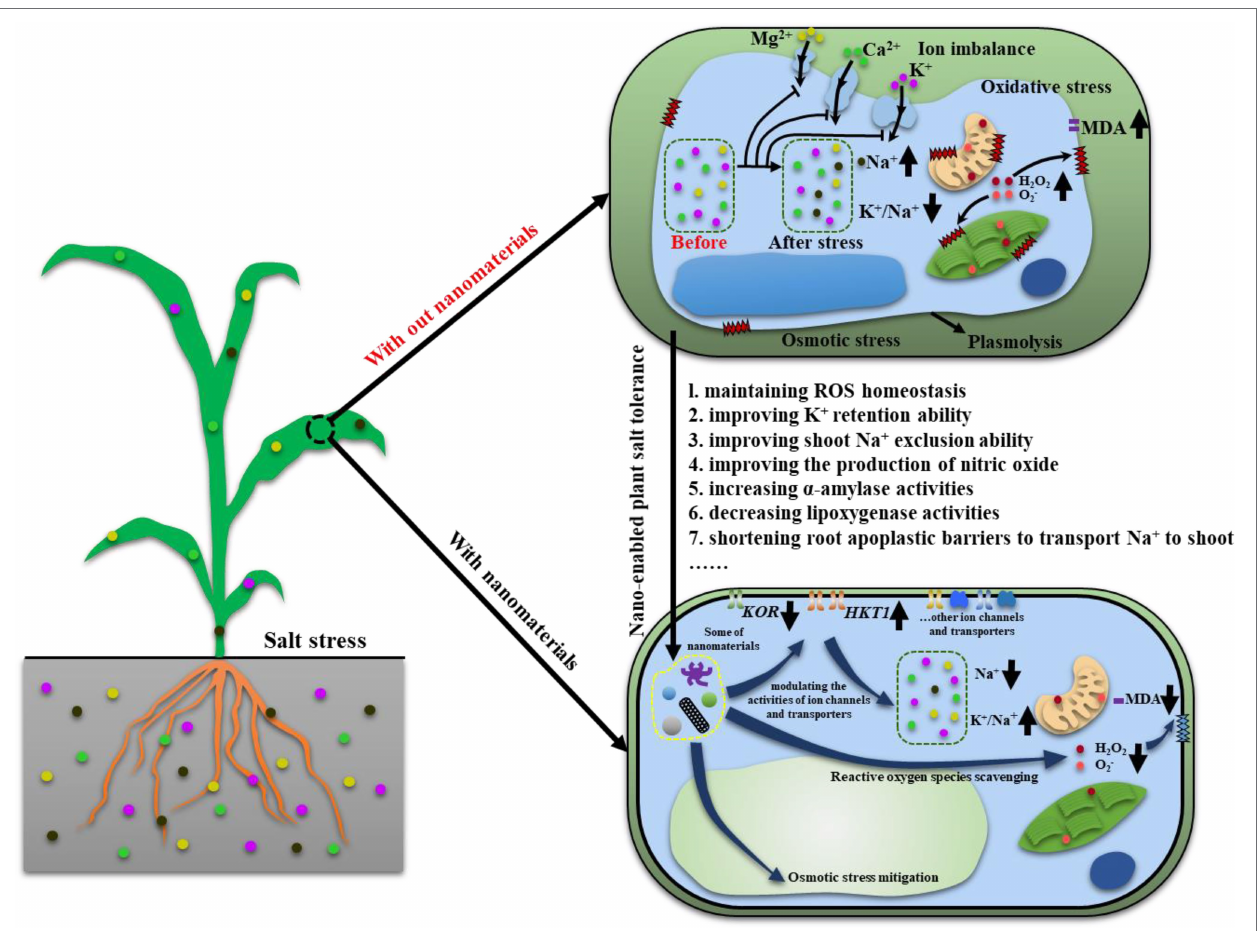
FIGURE 2 | A model showing how nanomaterials can help with maintaining osmotic balance, ion homeostasis and ROS homeostasis. ↑ : increase, ↓ : decrease, ┤ :